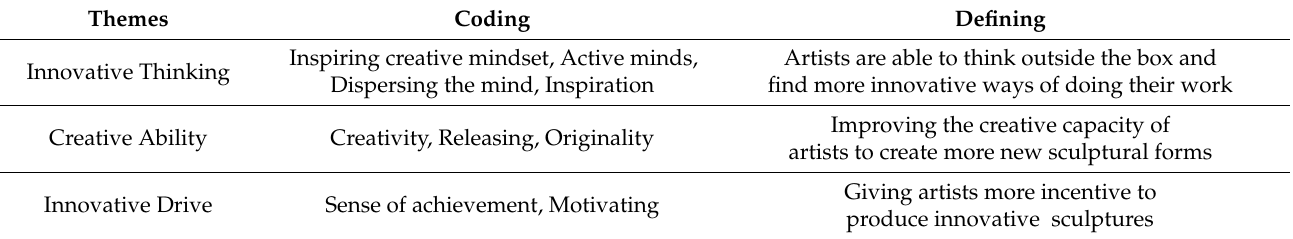
Table 3. Self-actualisation needs, coding themes, and defining